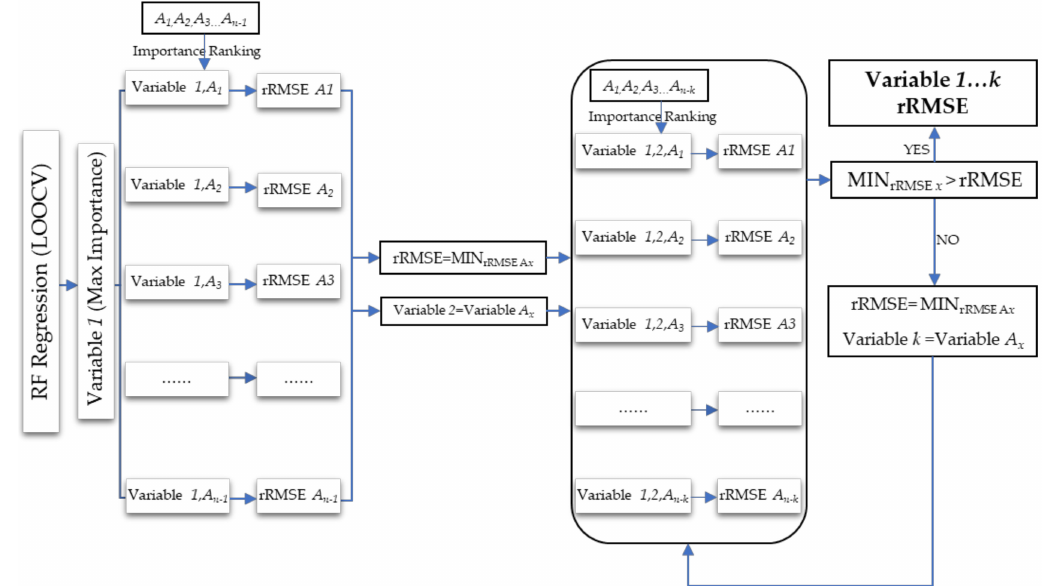
Figure 5. Feature variable selection process of the stepwise random forest (SRF) method.